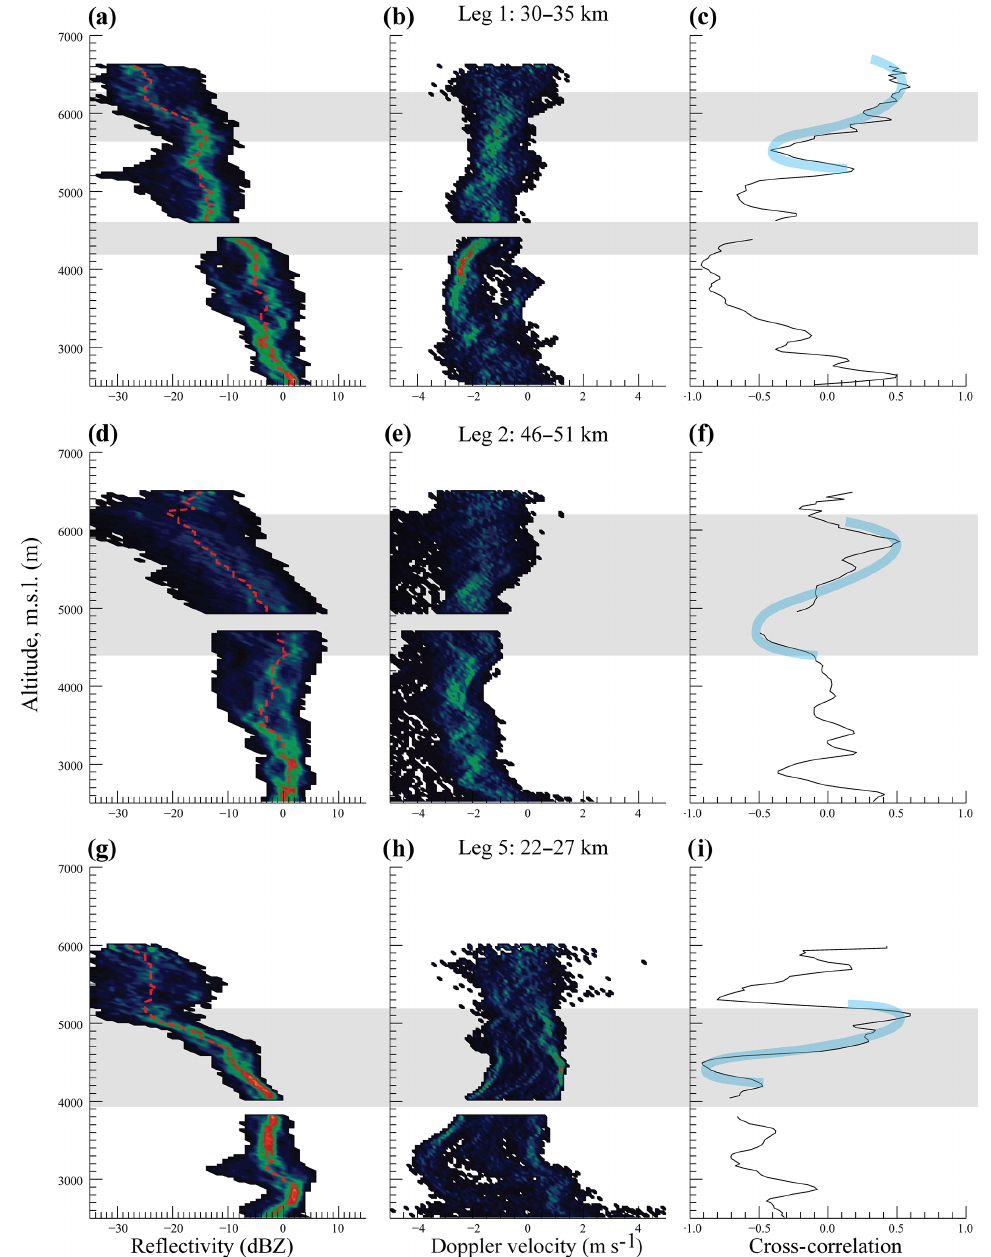
Figure 12. CFADs of reflectivity; Doppler velocity; and their zero-lag cross-correlation for the legs 1, 2, and 5 (from top row to bottom row, respectively, with relative distances downwind of PJ indicated at the top of each row). The dashed red line (left column) is median reflectivity for a vertical level and frequency is normalized for each vertical level (the same colors at the top as any other level). Vertical profiles of zero- lag cross correlation between reflectivity and Doppler velocity are shown in the right column, with reverse S correlation patterns highlighted in light blue. Shading indicates the primary inferred-growth regions within the elevated cellular